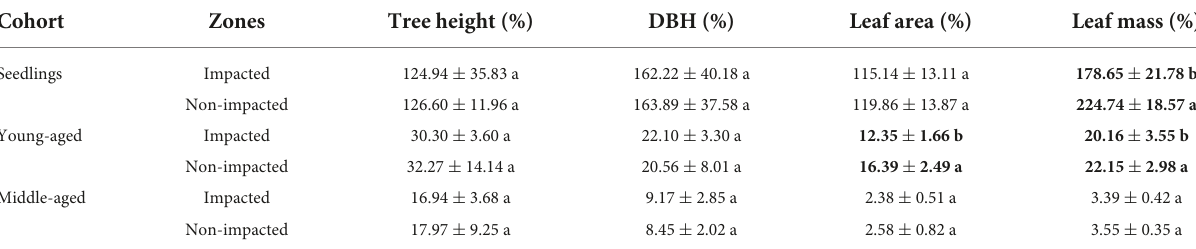
TABLE 2 Relative tree growth and leaf characteristics changes of Chinese tallow in cold spell impacted (Taizhou city) and non-impacted (Xiangshan county) zones by cohort age. Cohort Zones